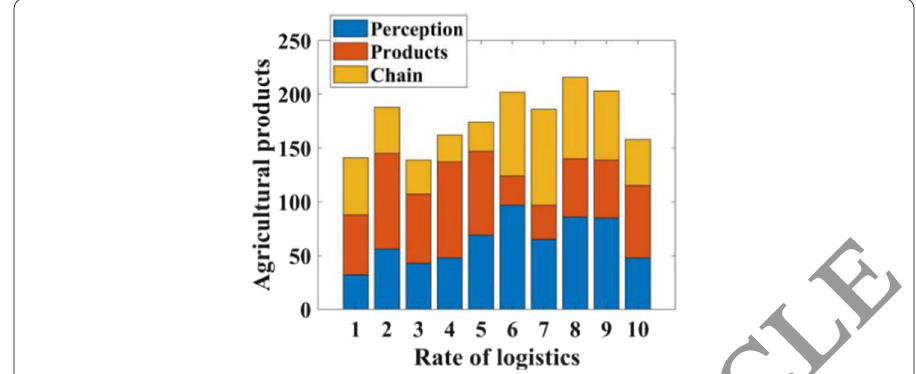
Fig. 4 Data on water solubility of tennis balls and rackets